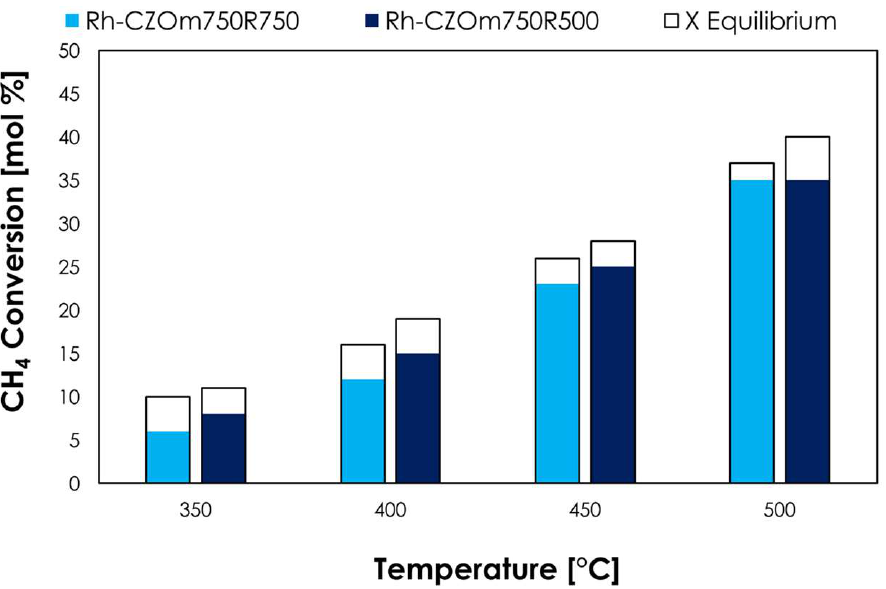
Figure 10. Methane conversion (colored bars) and equilibrium conversion (transparent bars) for LTSR at 1 atm, S/C = 3 and 24,000 h −1 for Rh-CZOm750-R500 and Rh-CZOm750-R750. at 1 atm, S/C = 3 and 24,000 h − 1 for Rh-CZOm750-R500 and